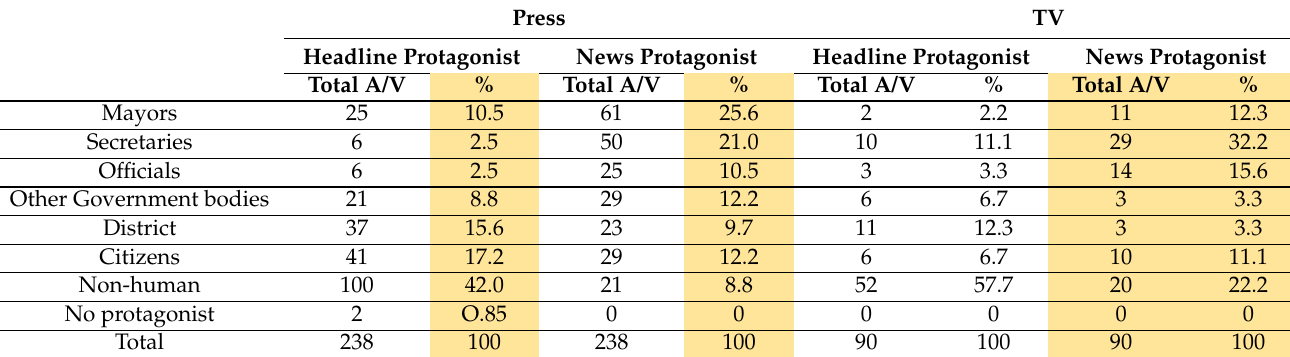
Table 6. Protagonists of the headlines and news items (Source: